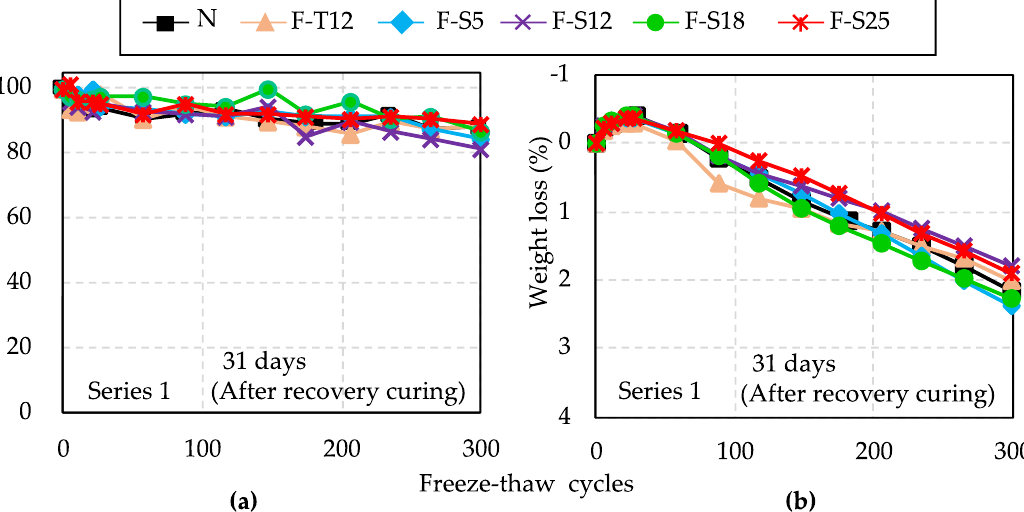
Figure 7. Results of relative dynamic modulus of elasticity ( a ) and weight loss ( b ) after 300 freeze– thaw cycles in Series 1.